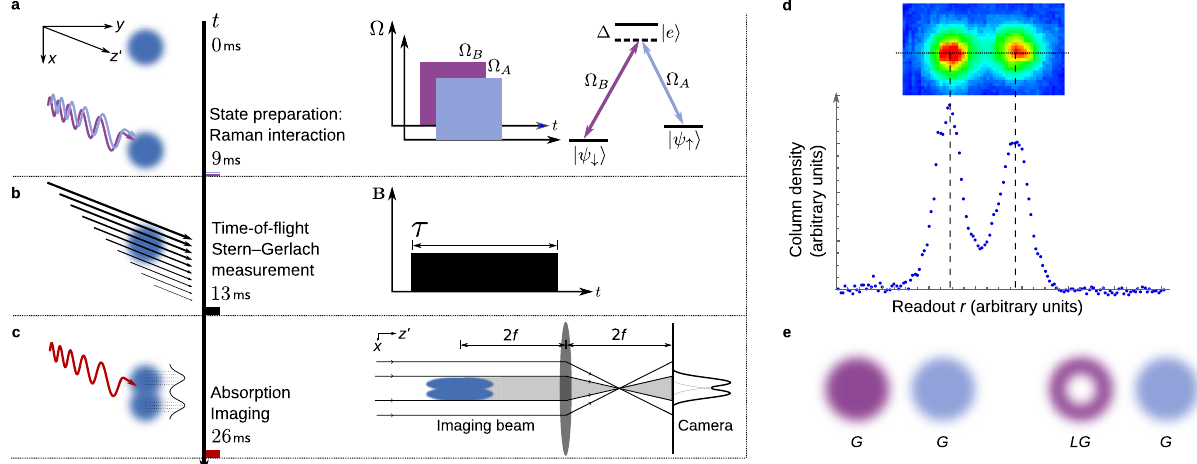
(cid:4) (cid:4) Fig. 1 Experimental sequence for weakly measuring the quantum spin of an ultracold atomic cloud. a We prepare the ultracold atomic cloud in a E E (cid:4) (cid:4) (cid:4) (cid:4) coherent superposition of spin states ψ " and ψ # with a coherent two-photon Raman interaction using laser fi elds with Rabi frequencies Ω A and Ω B . b The cloud, under free fall through an inhomogeneous magnetic fi eld B pulsed on for a time τ , receives a spin-state-dependent momentum kick. The black arrows show the Stern – Gerlach magnetic fi eld that maintains the quantization axis along z 0 (where we use the primed variable for the lab coordinate z 0 to distinguish from coordinates on the Bloch sphere), but with a gradient in the direction of gravity, x . c The spin state is correlated with the readout variable r , corresponding to position of atoms in the cloud, after a time of fl ight t f . Absorption imaging of the ultracold cloud with a 4 f imaging system yields the spatially resolved cloud column density (integrated over the z 0 direction), which provides a single-shot ensemble average of spin measurement. d Data are processed by taking a lineout through the center of the cloud that is fi t to two Gaussians (for uniform initialization of the cloud). Noise in the imaging process results in negative recorded values for the cloud column density in some pixels (see Supplementary Note 1). These negative values are disregarded in the fi t. e A uniform initialization of the cloud uses Raman beams with Gaussian (G) modes. The transverse spatial pro fi les are Gaussian functions. An orbital angular momentum degree of freedom is encoded in the cloud using Raman beams with Laguerre – Gaussian (LG) and G modes. The transverse spatial pro fi le of the LG mode is a donut. This results in an asymmetry between the spatial modes of the spin states in the fi nal absorption image when the cloud is initialized into a spin – orbit entangled state (see